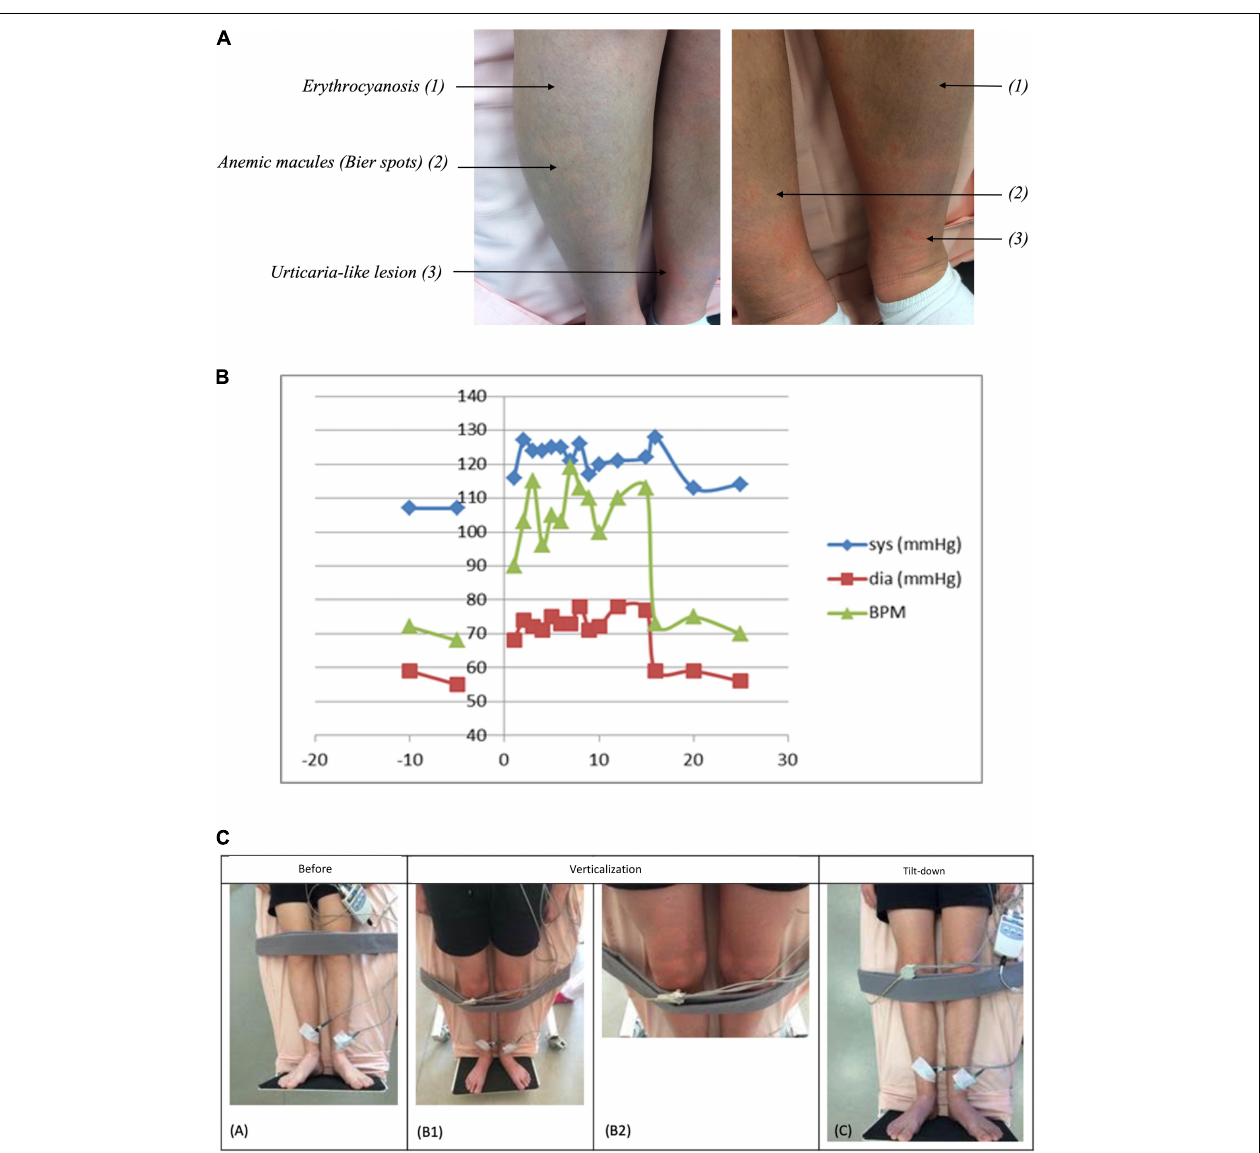
FIGURE 2 | (A) Bier Anemic spots, cyanosis, and urticaria-like eruption (BASCULE) of lower limbs while orthostatism in a 14-year-old patient. Skin eruption is characterized by erythrocyanic background (1) with anemic macules (Bier spots) (2), and urticaria-like eruption (3). (B) Blood pressure and heart rate evolution during tilt-test. The blue curve represents the systolic pressure, the red curve represents the diastolic pressure, and the green curve represents the average heart rate as a function of time before and after tilt-test. After verticalisation, heart rate increased to 110–120 bpm while blood pressure remained around 120/70 mmHg, which is characteristic of a postural orthostatic tachycardia syndrome (POTS) associated with cerebral hypoperfusion–symptoms include lightheadedness, syncope, palpitations, and fatigue. This condition is associated with an increase in heart rate > 30 bpm (or > 40 bpm in children/adolescents younger than 19 years) within 10 min of standing (or during a head-up tilt-test to at least 60 ◦ ) in the absence of orthostatic hypotension. (C) Clinical course during the tilt-test. Clinical features before the tilt-test (A) , during the tilt-test (B1,B2) , and after the tilt-test (C)